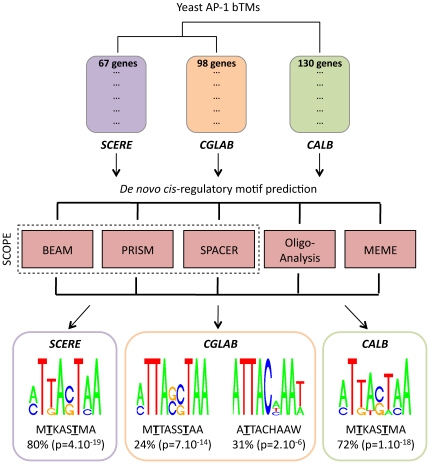
Identification of cis-regulatory motifs in promoter sequences of AP-1 bTM genes.Yeast AP-1 bTMs were characterized using the procedure presented in Figure 1. They are represented here using the following color code: Yap1p bTM in S. cerevisiae (SCERE) in purple, Cgap1p bTM in C. glabrata (CGLAB) in orange, Cap1p bTM in C. albicans in green. Promoter sequences of genes were analyzing using a combination of five different algorithms (BEAM, PRISM, SPACER, Oligo-Analysis and MEME) and applying a filter procedure to select the most significant motifs (see Material and Methods and Text S3). 12 motifs were identified in SCERE, 7 motifs in CGLAB and 8 motifs in CALB. They are presented in Text S4. In each species, these motifs were combined and consensus sequences are shown here (SeqLogo representations). A unique consensus MTKASTMA was observed in promoters of SCERE and CALB genes and two consensuses (MTTASSTAA, ATTACHAAW) were observed in promoters of CGLAB genes (where M designates A or C, K designates G or T, S designates C or G and W designates A or T). Percentages of genes in each AP-1 bTMs that exhibit those consensuses are indicated below the SeqLogo representations, with the associated enrichment p-value (see Materials and Methods). Highly conserved positions between the consensuses are underlined. They are predicted to strongly interact with the TF DNA binding domain, based on structural inspection of the Pap1p/DNA complex (see Figure 4).